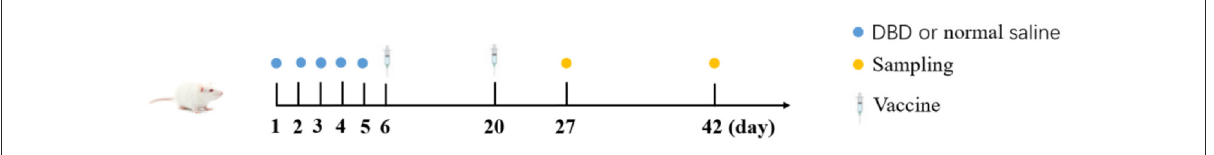
FIGURE1 Grouping and processing in mice.